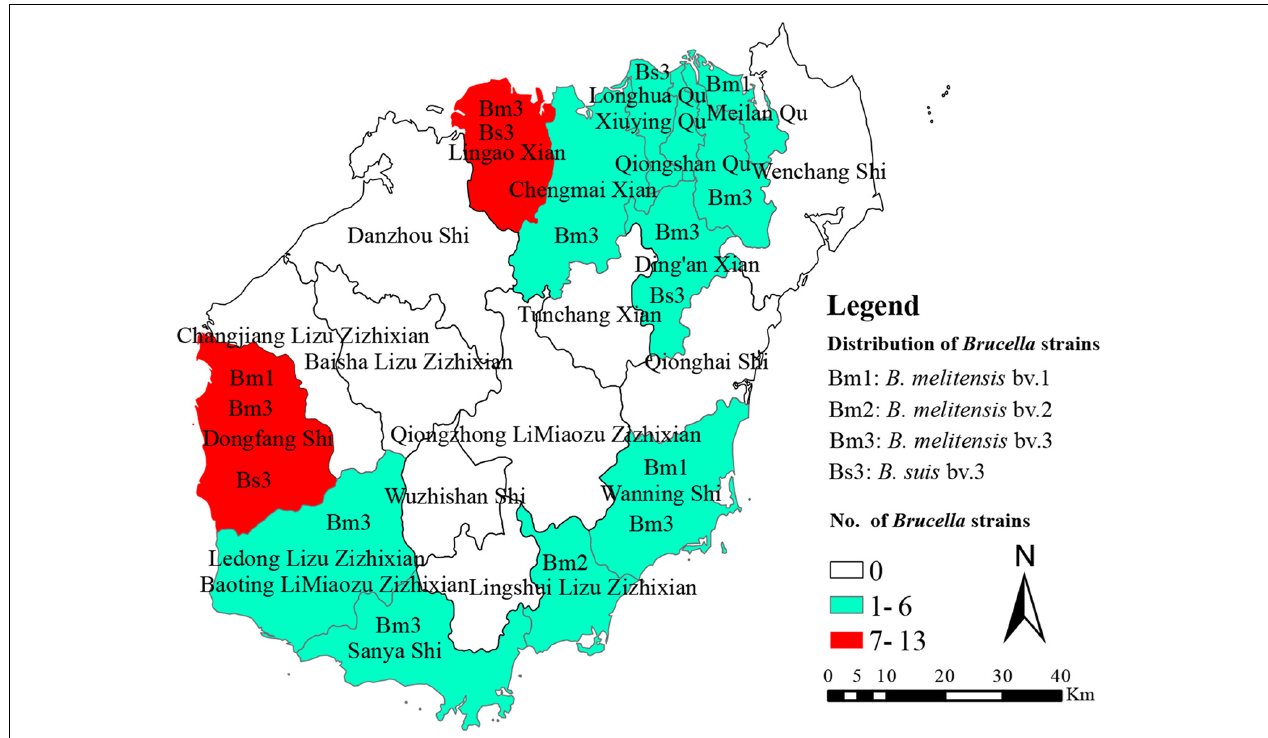
FIGURE 1 | The geographic distribution of Brucella samples in Hainan, China. The map of Hainan province in this study was download from open source map (https://commons.wikimedia.org/wiki/Atlas_of_the_world).